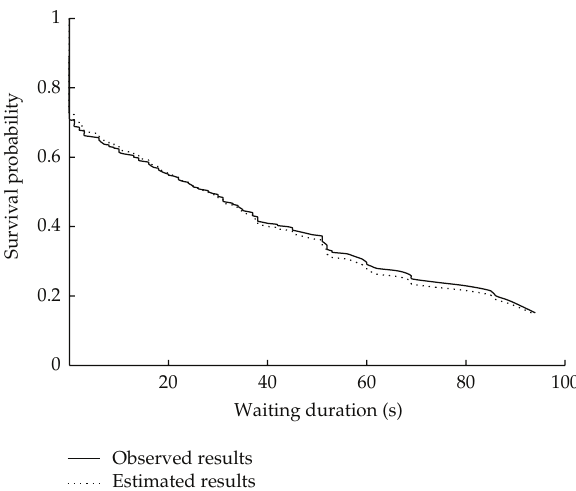
Figure 1: Survival probabilities versus waiting